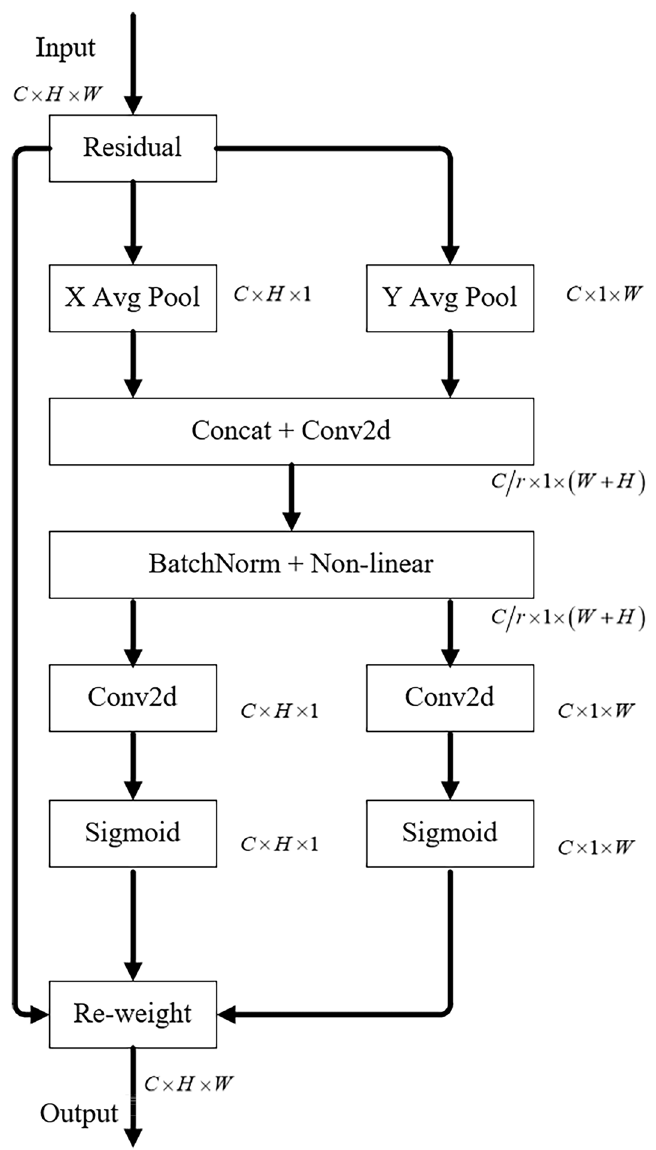
Figure 2. The coordinate attention block, where X Avg Pool and Y Avg Pool represent 1D horizontal global pooling and vertical global pooling,